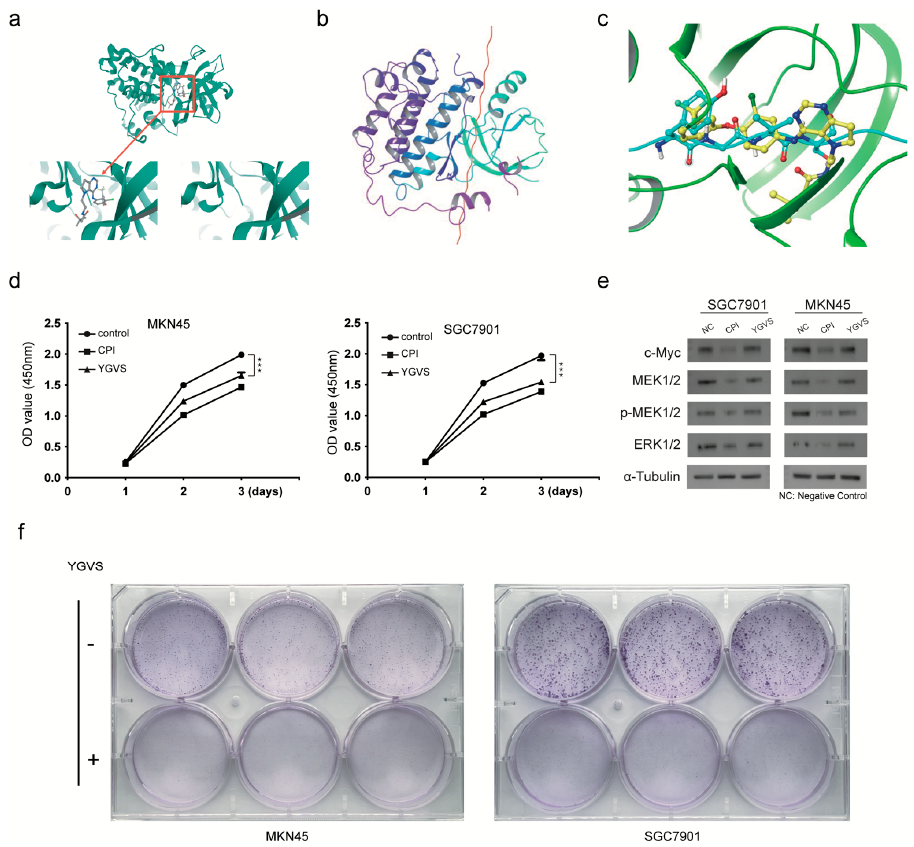
Figure 5. Screening of the lead compounds for the treatment of gastric cancer based on the effective peptide fragments of the Bombyx mori carboxypeptidase inhibitor recombinant protein. ( a ) Successful removal of the original small molecule ligand of the receptor. ( b ) Molecular docking of the silkworm carboxypeptidase inhibitor with the EGFR kinase domain. ( c ) The action site of the silkworm carboxypeptidase inhibitor peptide overlaps with the small molecule inhibitor tak-285. ( d ) The effective polypeptide of the silkworm carboxypeptidase inhibitor significantly inhibited the proliferation of gastric cancer cells. ( e ) Effective polypeptides of silkworm carboxypeptidase inhibitors affect the expression of MAPK/ERK pathway proteins. ( f ) Effective Bombyx mori carboxypeptidase inhibitor polypeptides inhibit gastric cancer cell colony formation. The differences between the experimental and the control groups were analyzed by the Student’s t test, *** p < 0.001.